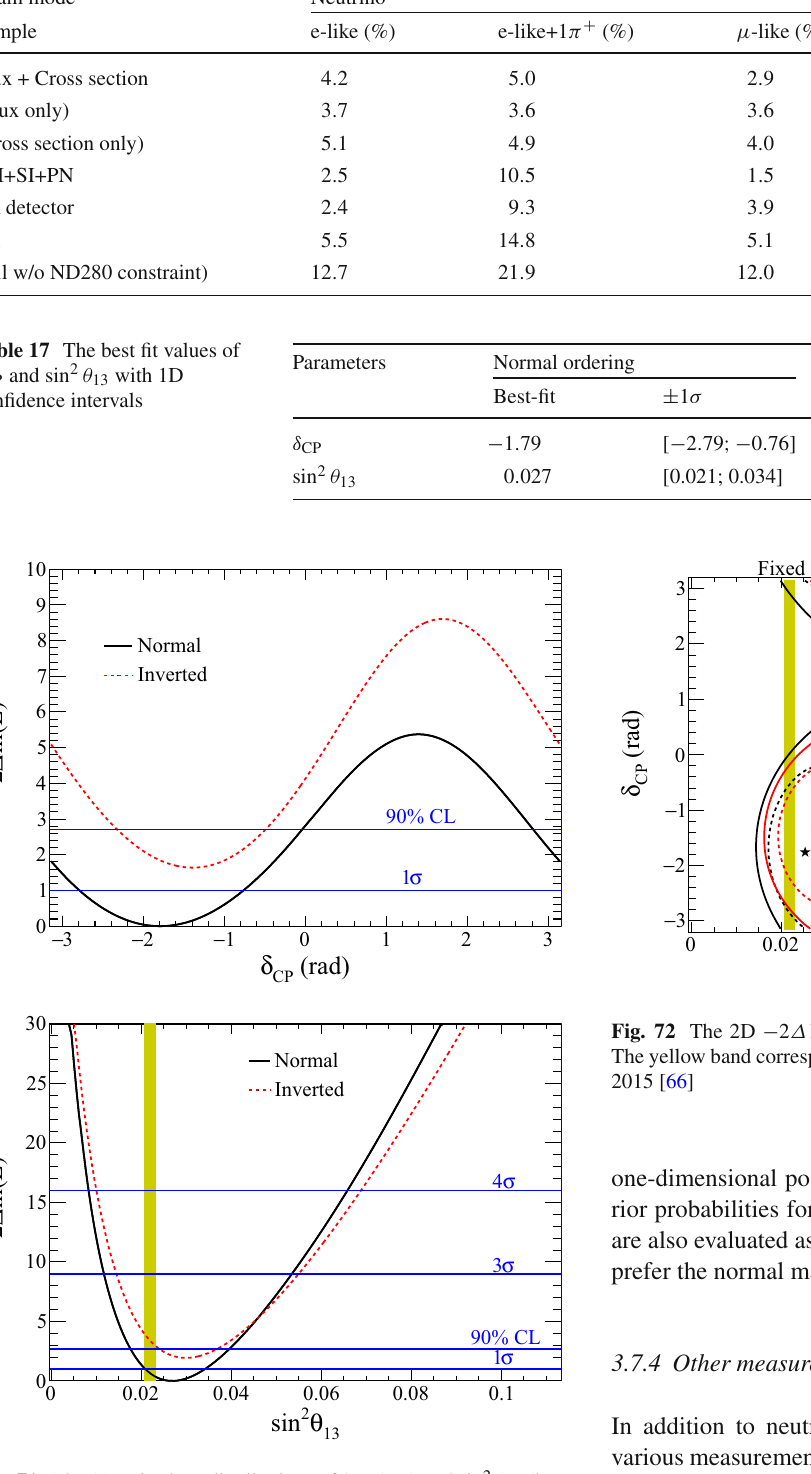
Fig. 71 The 1D − 2 Δ ln L distributions of δ CP (top) and sin 2 θ 13 (bot- tom) from [62]. The yellow band corresponds to the reactor value of sin 2 θ